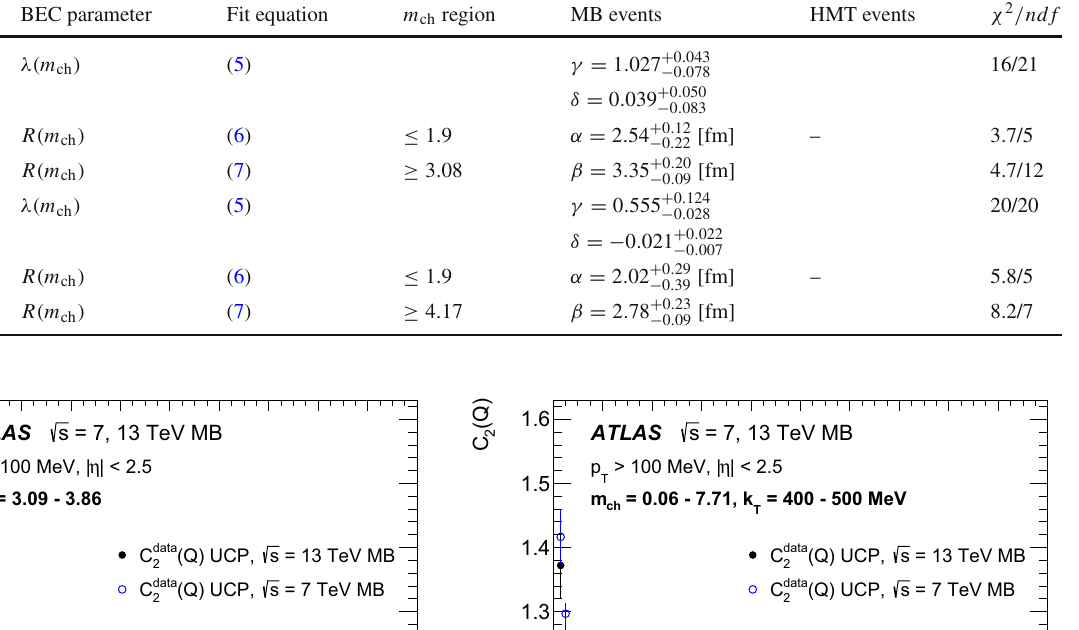
Table 2 The results of the fits to the dependencies of the correlation strength, λ , and source radius, R , on the average rescaled charged- particle multiplicity, m ch , for | η | < 2 . 5 and both p T > 100 MeV and √ p T > 500 MeV at s = 13 TeV for the minimum-bias (MB) and the